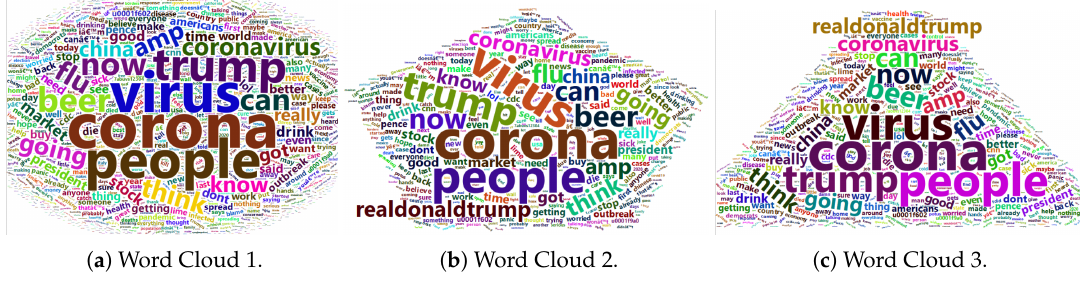
Figure 4. A couple of word cloud